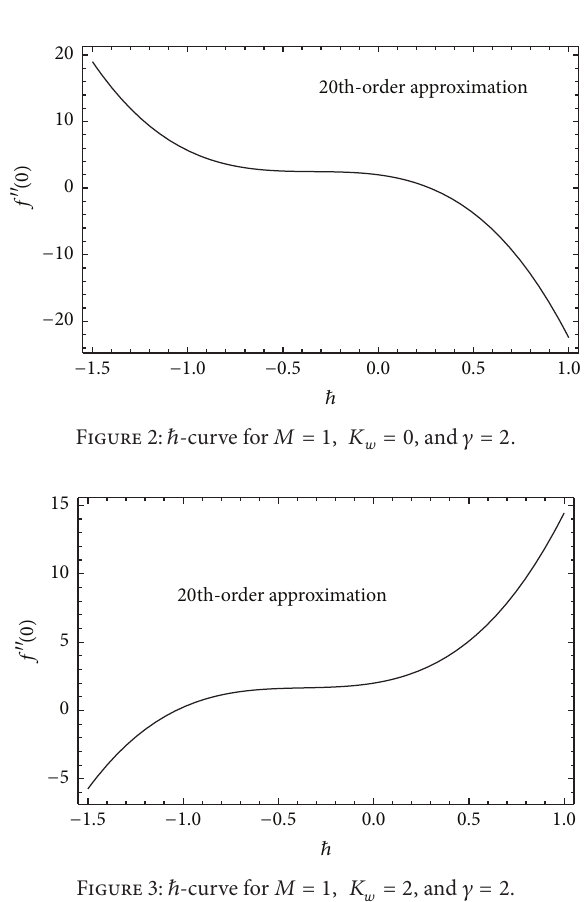
Figure 3: ℎ -curve for 𝑀 = 1, 𝐾 𝑤 = 2 , and 𝛾 = 2